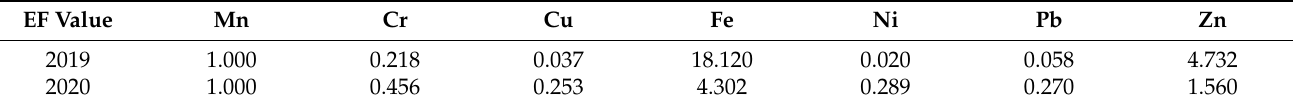
Table 3. Enrichment factor of